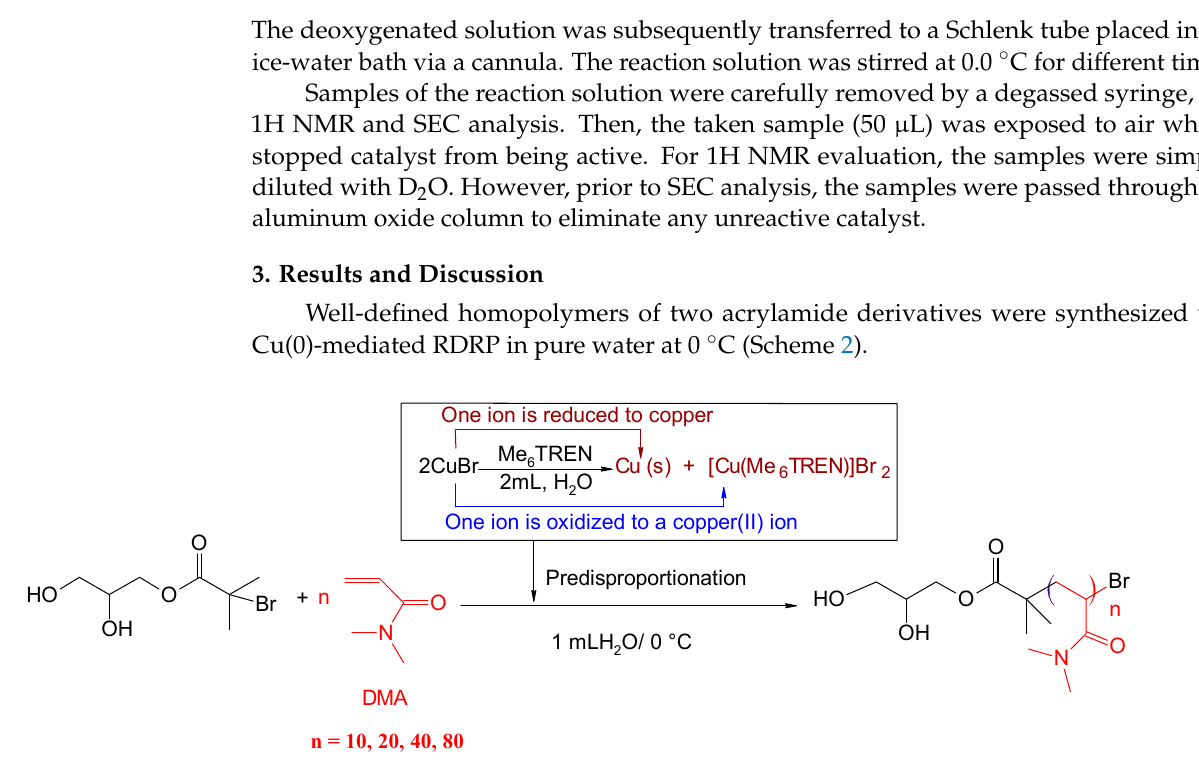
Scheme 2. Synthesis of polydimethylacrylamide (PDMA) (degree of polymerization (DP) = 10, 20, 40, and 80) by Cu(0)-